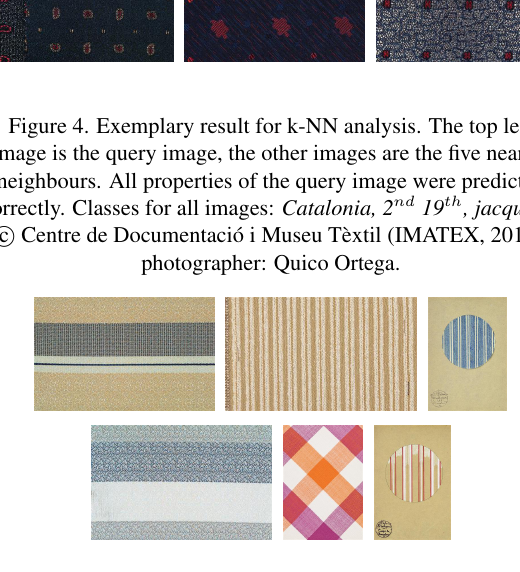
Figure 5. Exemplary result for k-NN analysis. The top left image is the query image, the other images are the five nearest neighbours. Here, the k-NN classification predicted only the production place ( Catalonia ) correctly. The majority vote from the nearest neighbours for the production timespan ( 1 st 20 th ) and technique ( drawing ) lead to false predictions. photographer: Quico